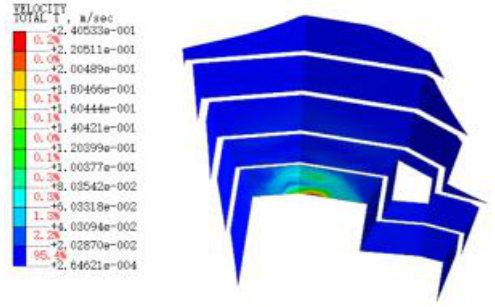
Figure 16. The vibration velocities of retaining walls at 100 ms.